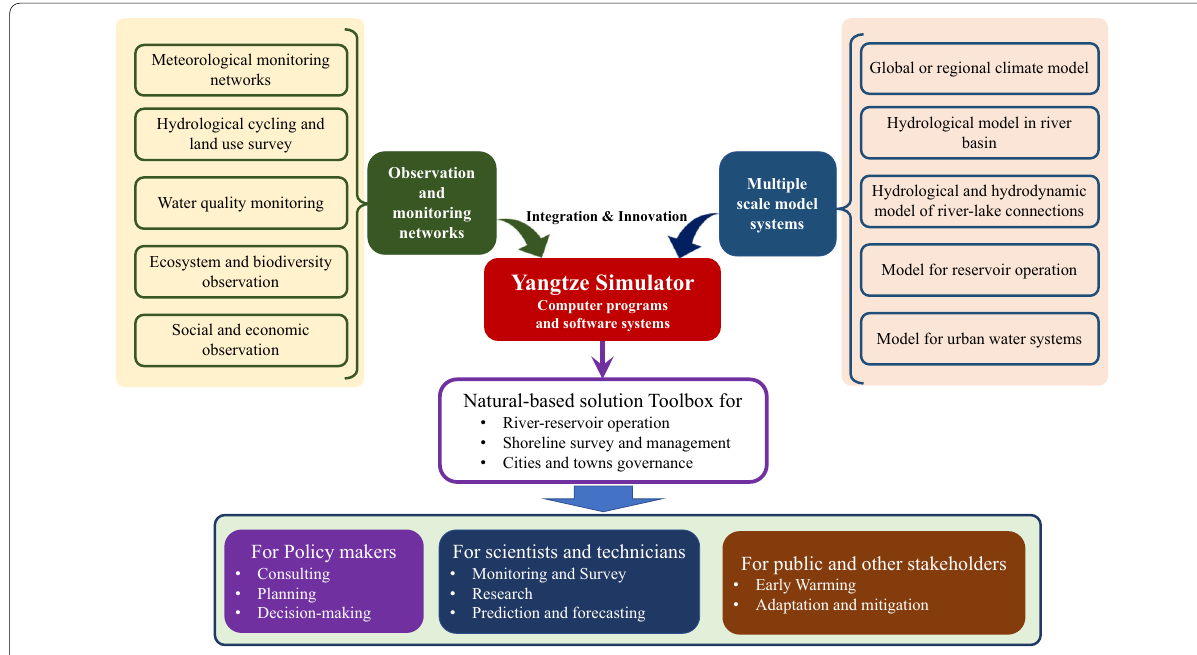
Fig. 4 Framework of the Yangtze